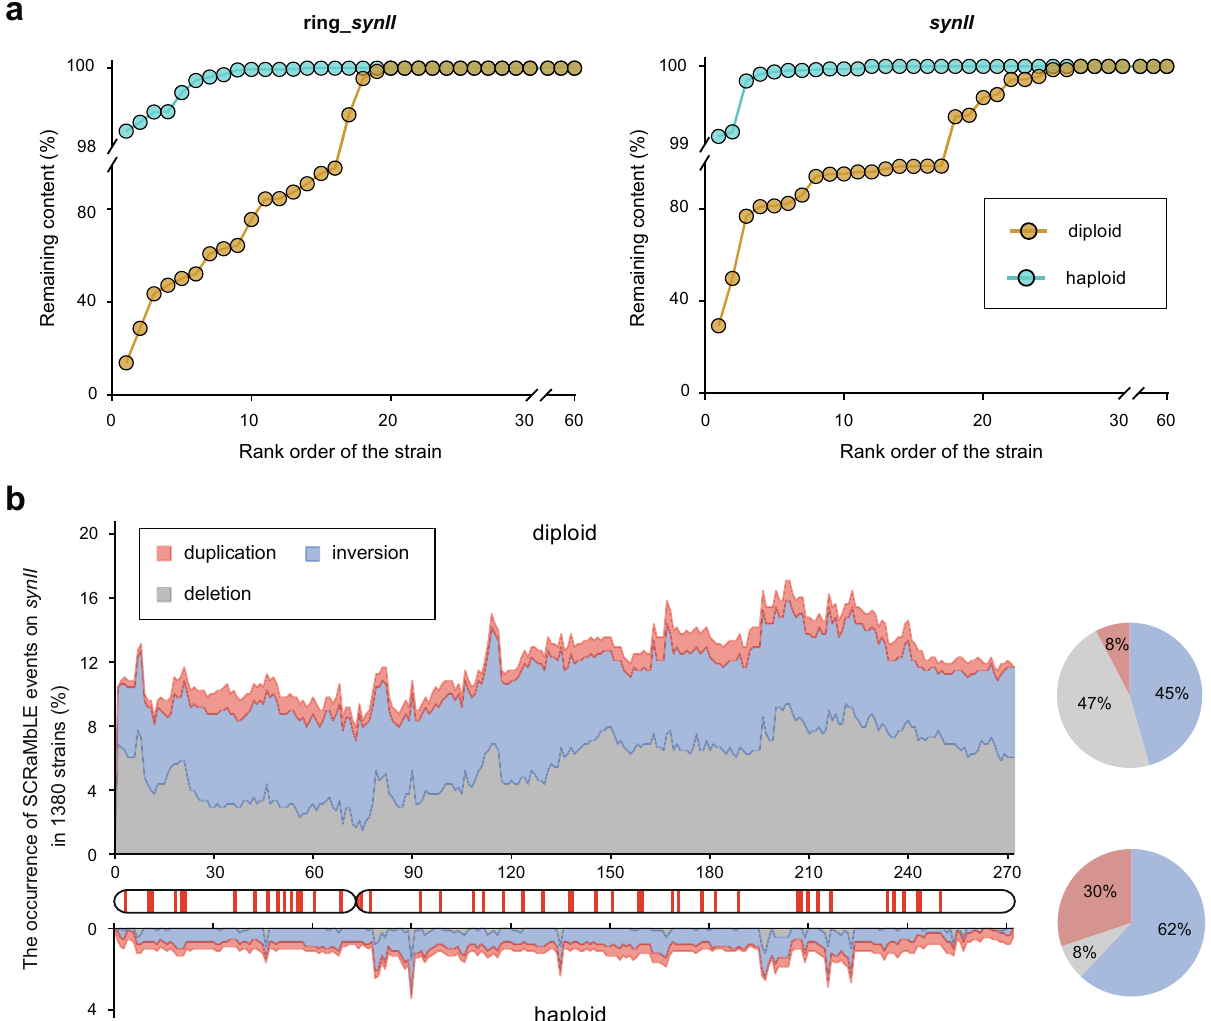
Fig. 4 | The comparison of chromosome content loss and proportion of rear- rangement types between haploid and diploid cells subjected to GCE- SCRaMbLE. a The comparison of retention rate of synthetic chromosomes ( synII andring_ synII )betweendiploidandhaploidstrainsafterGCE-SCRaMbLEunderthe same condition. 60 haploid and diploid yeast cells carrying ring_ synII were respectively subjected to GCE-SCRaMbLE using Cre UAG14 induced by 5mM OMeY (left). 60 haploid and diploid yeast cells carrying 4 synthetic chromosomes ( synII , synIII , synVI , synIXR ) were respectively subjected to GCE-SCRaMbLE using Cre UAG5 induced by 1mM OMeY (right). Haploid and diploid strains are indicated with sky blue and golden yellow dots, respectively. b The comparison of synII SCRaMbLE